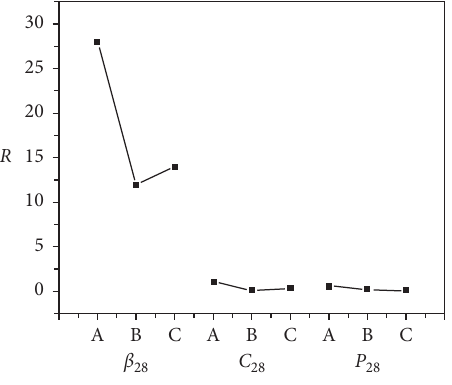
Figure 3: Results of range analysis.